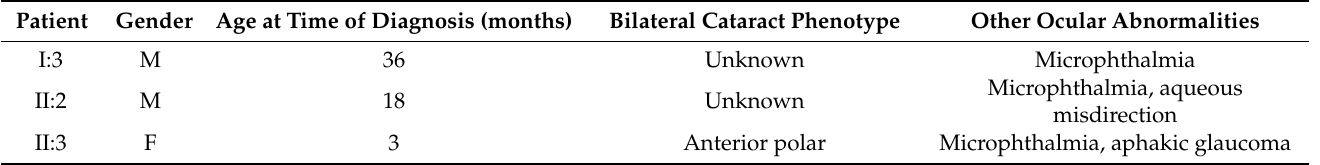
Table 1. Clinical features of 3 family members with cataract.